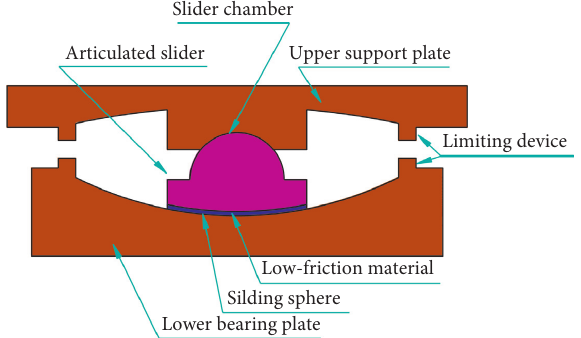
Figure 3: Structural sketch of